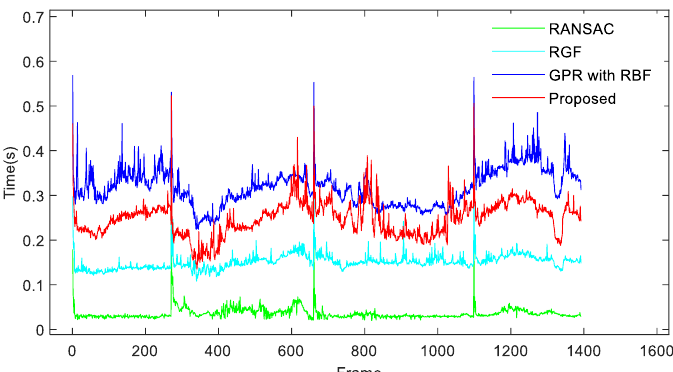
Figure 10. Time consumption comparison of four algorithms on four